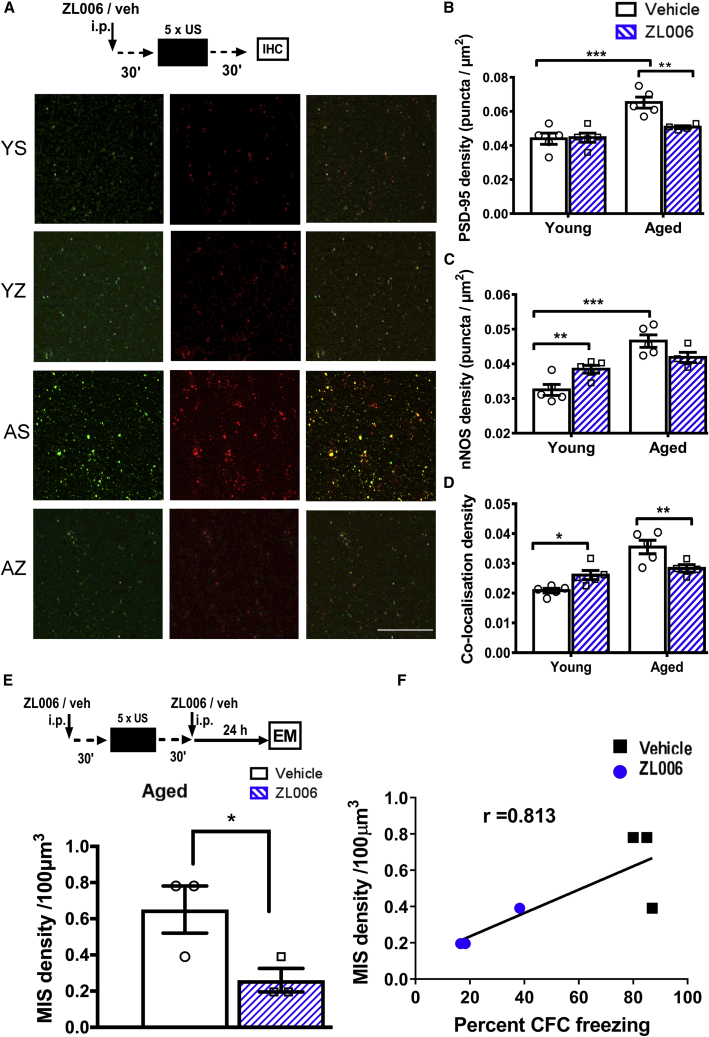
ZL006 Blocked PSD-95-nNOS-Mediated Upregulation of MISs in Aged Mice(A) Experimental design to study the impact of ZL006 treatment on PSD-95 and nNOS and representative images showing PSD-95 (green) and nNOS (red) puncta and merged images in dorsal CA1 stratum radiatum. The scale bar represents 10 μm. nYveh = 5, nYZL006 = 5, nAveh = 5, nAZL006 = 4.(B) ZL006 significantly reduced PSD-95 expression in conditioned, aged, but not in conditioned, young mice (effect of age, F(1,15) = 21.5, p < 0.001; effect of treatment, F(1,15) = 5.90, p < 0.05; interaction age x treatment, F(1,15) = 6.2, p < 0.05; Tukey’s post hoc tests: ATveh versus ATZL006, p < 0.01; YTveh versus YTZL006, p < 0.001).(C) There was a statistical trend that ZL006 treatment reduced nNOS levels in aged mice (effect of age, F(1,15) = 32.0, p < 0.001; effect of treatment, F(1,15) = 0.17, p = 0.68; interaction age x treatment, F(1,15) = 12.0, p < 0.01; Tukey’s post hoc tests: YTveh versus YTZL006, p < 0.01; ATveh versus ATZL006, p = 0.053; YTveh versus ATveh, p < 0.001).(D) ZL006 reduced co-localization of PSD-95 and nNOS in conditioned, aged mice, whereas it surprisingly increased the co-localization in conditioned, young mice (n = 5 each, except nAZL006 = 4; effect of age, F(1,15) = 27.9, p < 0.001; effect of treatment, F(1,15) = 0.38, p = 0.54; interaction age x treatment, F(1,15) = 15, p < 0.01; Tukey’s post hoc tests: YTveh versus ATveh, p < 0.001; YTveh versus YTZL006, p < 0.05; ATveh versus ATZL006, p < 0.01).(E) ZL006 (10 mg/kg, i.p.) was administered 30 min before and 30 min after CFC, and 24 h after CFC an EM analysis was carried out. ZL006 treatment significantly reduced MIS density in aged mice 24 h after CFC (nveh = 3, nZL006 = 3; one-tailed t test, t(4) = 2.68, p < 0.05).(F) Scatterplot showing a positive correlation between freezing and MIS density 24 h after CFC. Data are from aged, ZL006-treated mice (blue circles) and aged, vehicle-injected mice (black squares) (n = 3 each; r = 0.813, p = 0.048, Pearson correlation).Mean ± SEM, ∗∗∗p < 0.001, ∗∗p < 0.01, ∗p < 0.05. Individual data plots representing each animal within the group overlay the bar graphs. See also Figures S6 and S7.